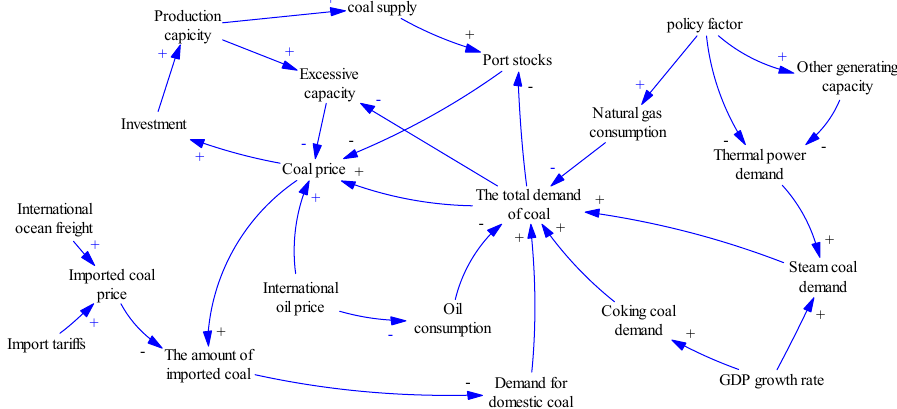
Figure 4. Causality diagram of coal price.